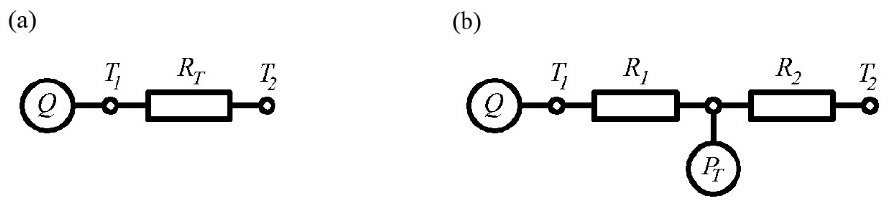
Figure 7. Variants of thermal replacement diagrams: ( a ) without heat emission and ( b ) with internal heat emission.